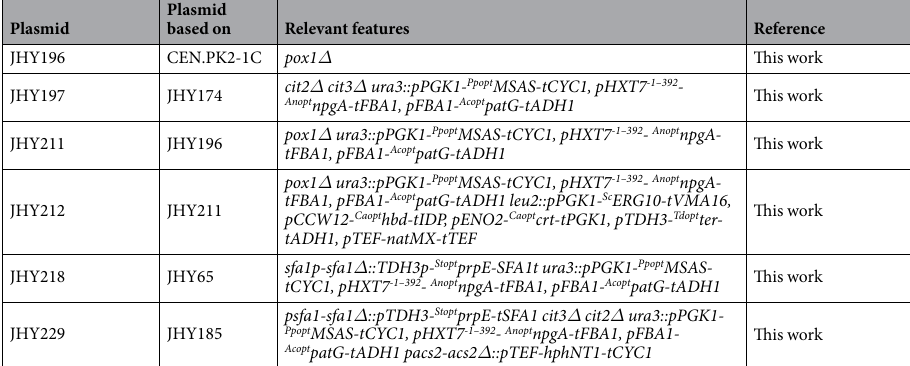
Table 1. Plasmids and yeast strains used in this study. Genes from Aspergillus nidulans (An), Aspergillus clavatus (Ac), Clostridium acetobutylicum (Ca), Penicillium patulum (Pp), Saccharomyces cerevisiae (Sc), Salmonella enterica serovar typhimurium (St), Treponema denticola (Td) and codon-optimized genes (opt) are indicated by prefixes in superscript. Other abbreviations: hphNT1 : hygromycin resistance; Amp r : ampicillin resistance; Cam R : chloramphenicol resistance; Kan R : kanamycin resistance; kanMX : geneticin resistance; natMX : clonat resistance. If not stated otherwise, promoters (p) were taken 1-500 bp upstream and terminators (t) 1-300 bp downstream of respective open reading